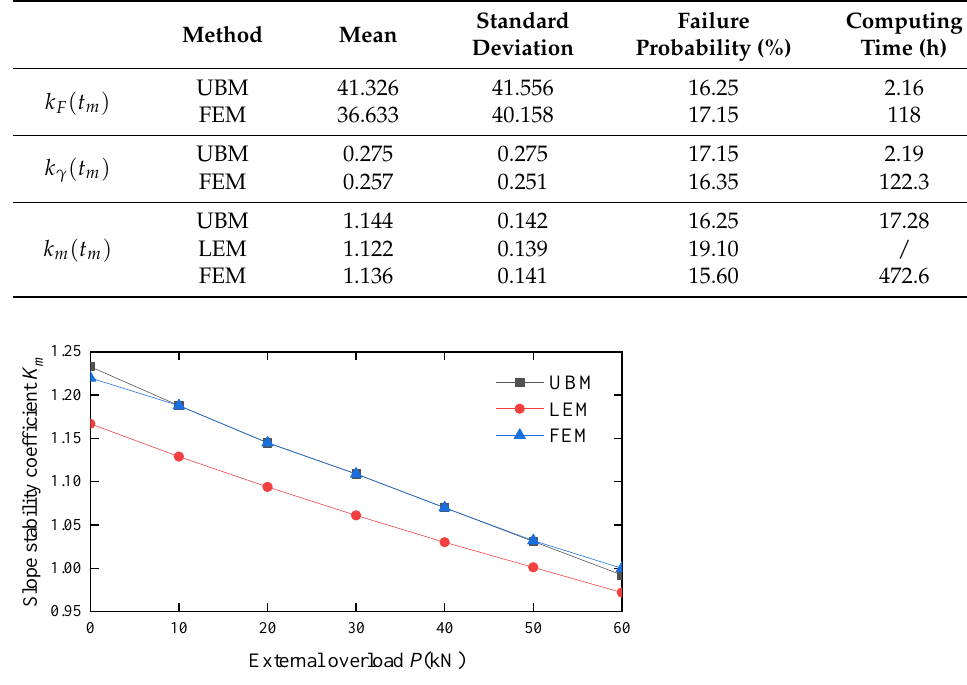
Figure 9. Relationship between external load and slope stability coefficient of heterogeneous slope.